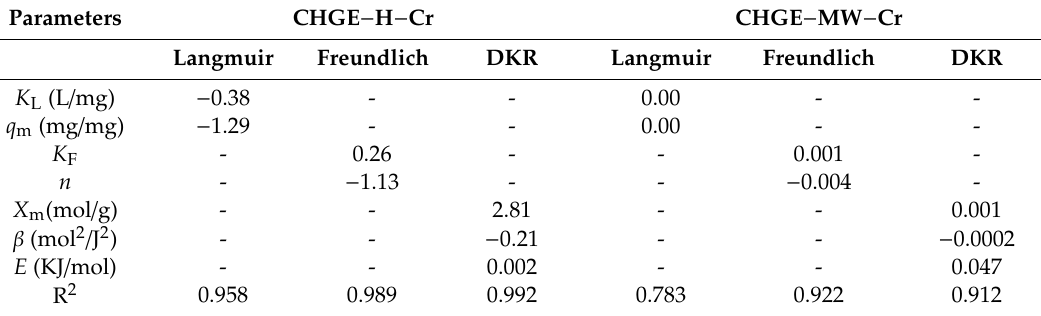
Figure 3. Linearized isotherms of DKR ( a ) for CHGE-H and ( b ) for CHGE-MW. Table 5. DKR parameters for CHGE-H-Cr and CHGE-M-Cr.